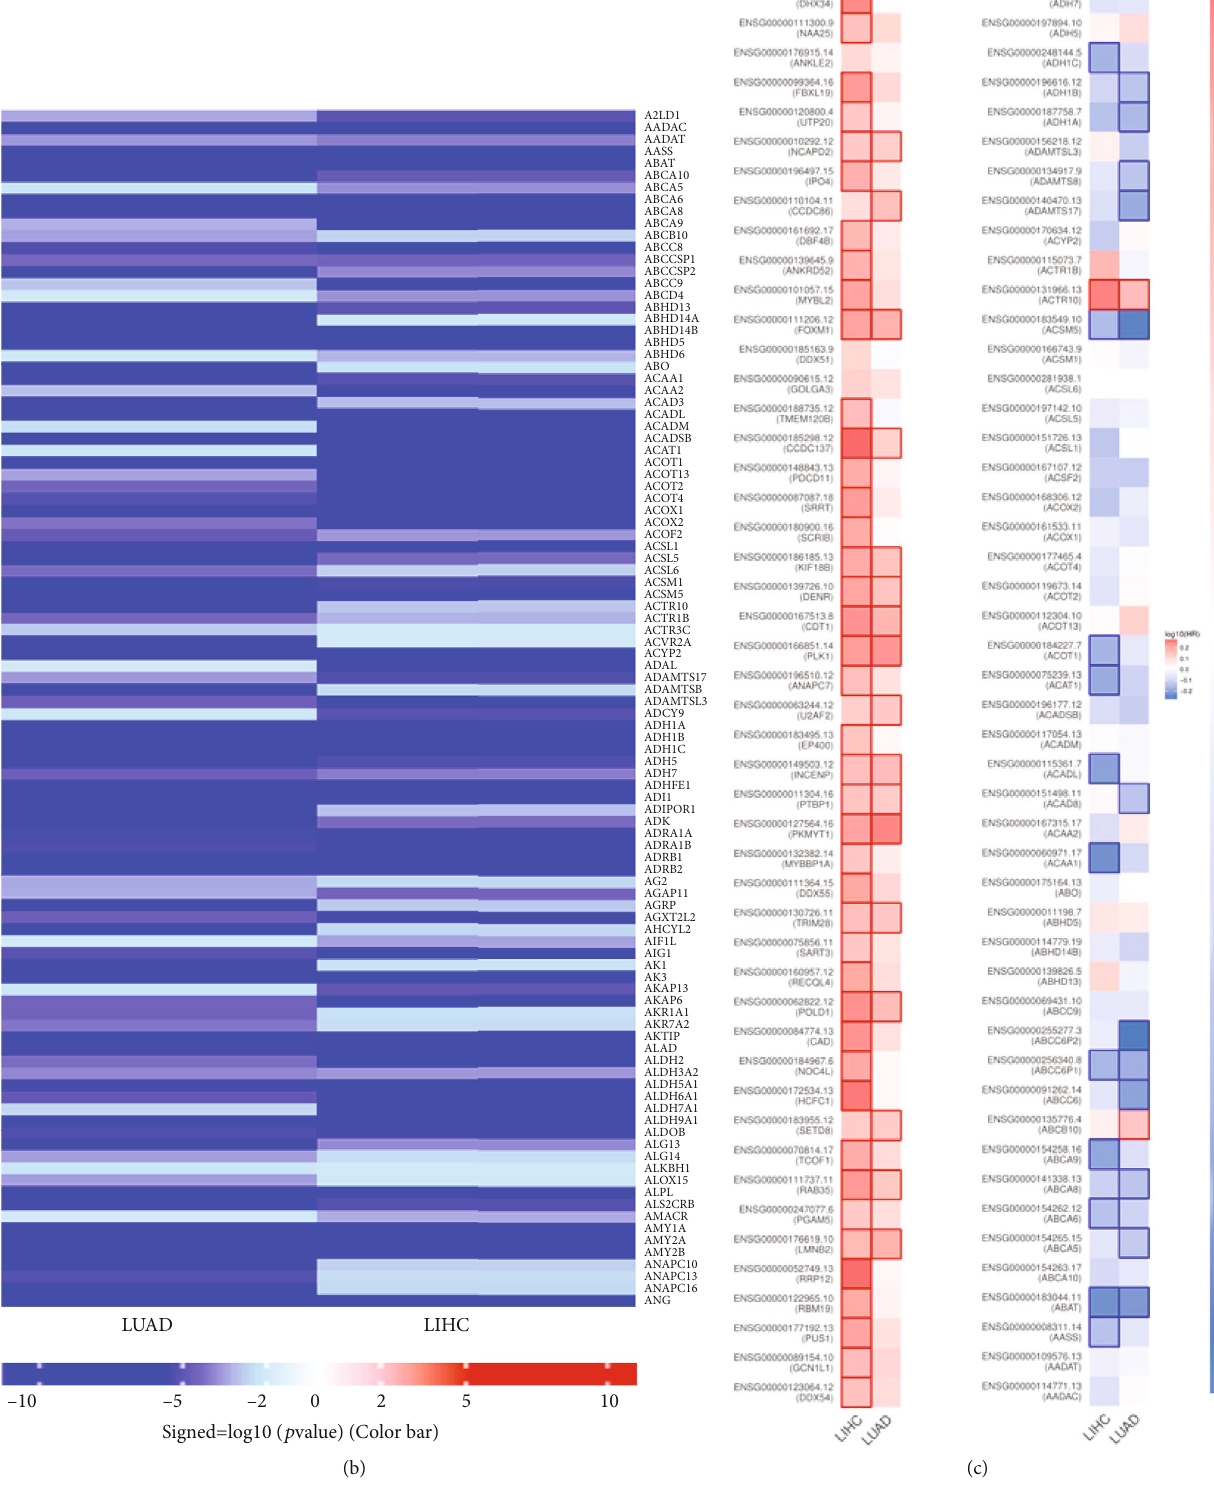
Figure 4: DHX37 coexpression genes in LIHC and LUAD (LinkedOmics). (a, b) Heat maps showing top 50 genes positively and negatively correlated with DHX37. (c) Survival map of the top 50 genes positively and negatively correlated with DHX37 in LIHC and